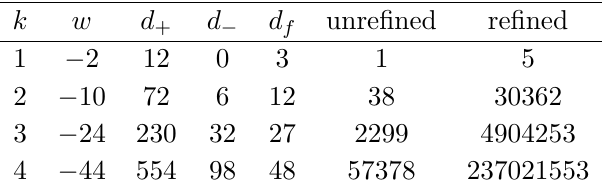
Table 13 . Numbers of possible terms in the numerator of the k -string for g = a invariant Jacobi